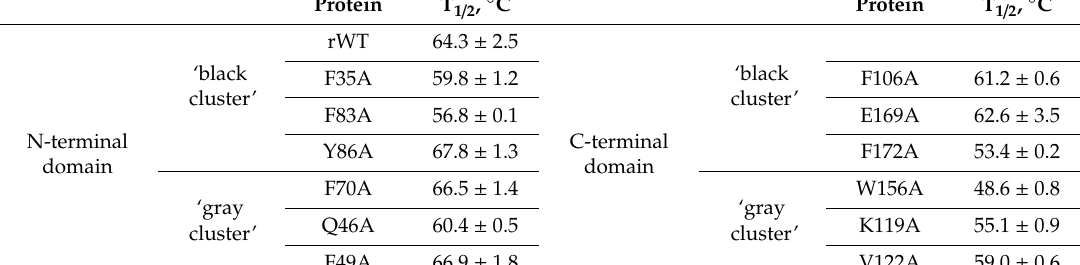
Table 3. Mid-temperatures, T 1 / 2 , of the thermal transitions of apo-states of rWT human recoverin and its cluster mutants monitored by far-UV circular dichroism method. The experimental data for ellipticity at fixed wavelengths (208, 216, and 222 nm) were approximated by sigmoidal curves and T 1 / 2 is a mean value for these three curves.